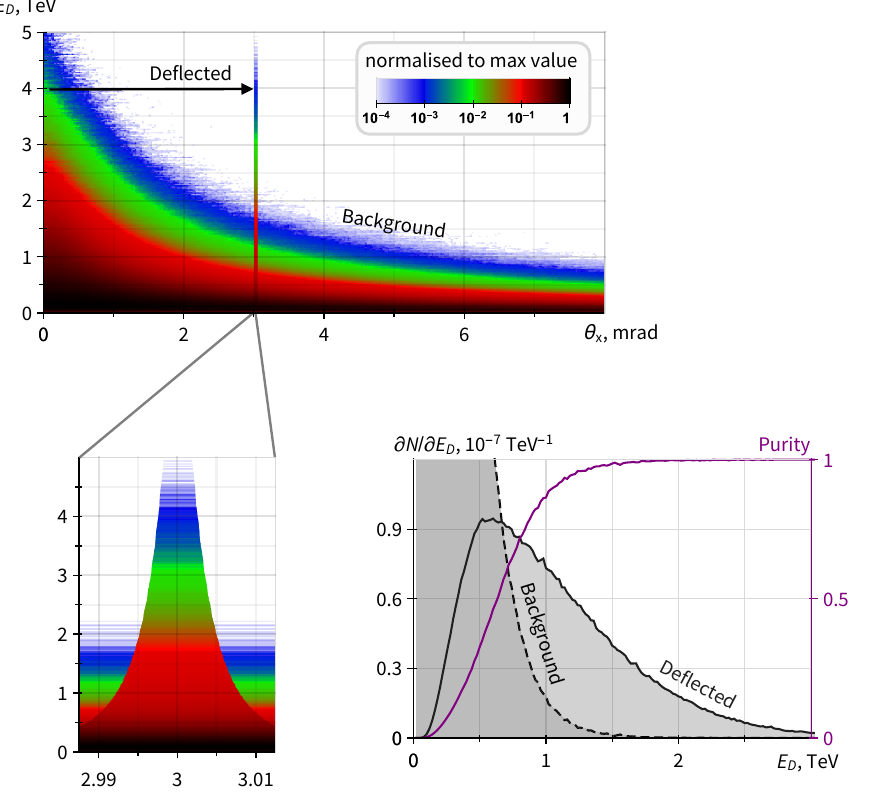
Figure 5 . Spectral angular distribution of D s mesons after the (cid:12)rst crystal. \De(cid:13)ected" describes a collimated D s beam de(cid:13)ected by a germanium crystal by (cid:2) D = 3 mrad; \Background", D + produced in the target. Purity is the ratio of de(cid:13)ected D +